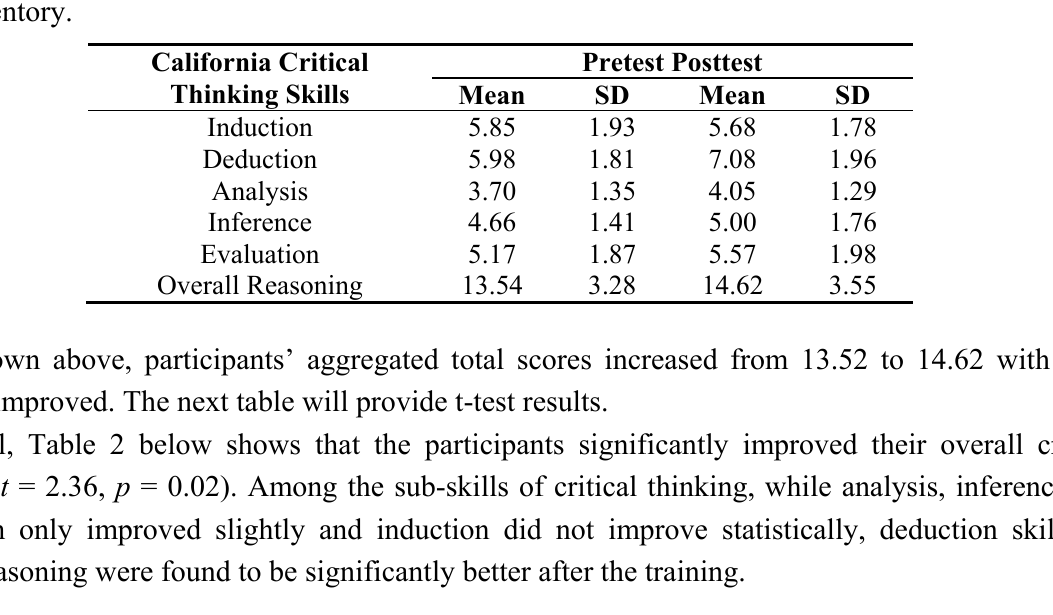
Table 2. Paired-sample T-tests between pretest and posttest. Paired